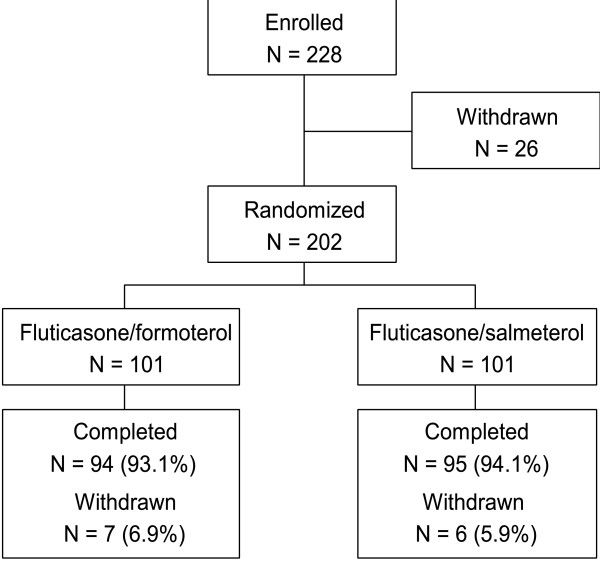
Participant flow.